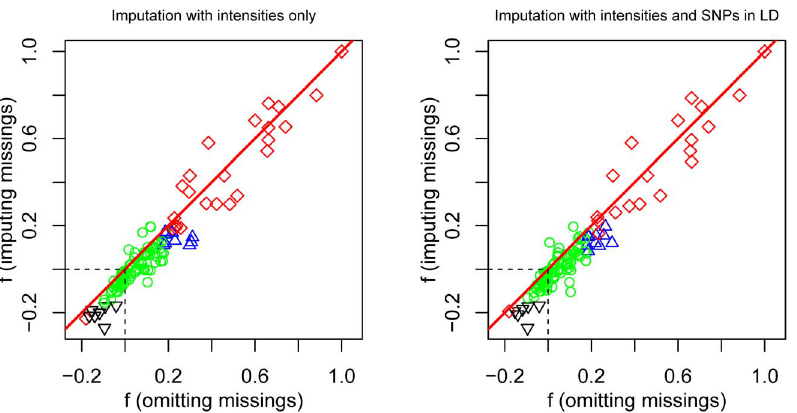
Figure 5. Estimation of inbreeding coefficients by multiple imputation and by omitting missings. Left panel: using allele intensities only. Right panel: using allele intensities and covariate SNPs in LD (complete and incomplete) with R 2 w 0 : 5 . Symbols indicate the result of two significance tests: a test for HWP discarding missings and a test for HWP with imputation of missings. Circles: SNPs with both tests non-significant; Diamonds: SNPs with both tests significant; Upward triangles: SNPs with a significant chi-square test when missings are omitted, but an insignificant test when missings are imputed. Downward triangles: SNPs with a non-significant chi-square test when missings are omitted, but a significant test when missings are imputed.